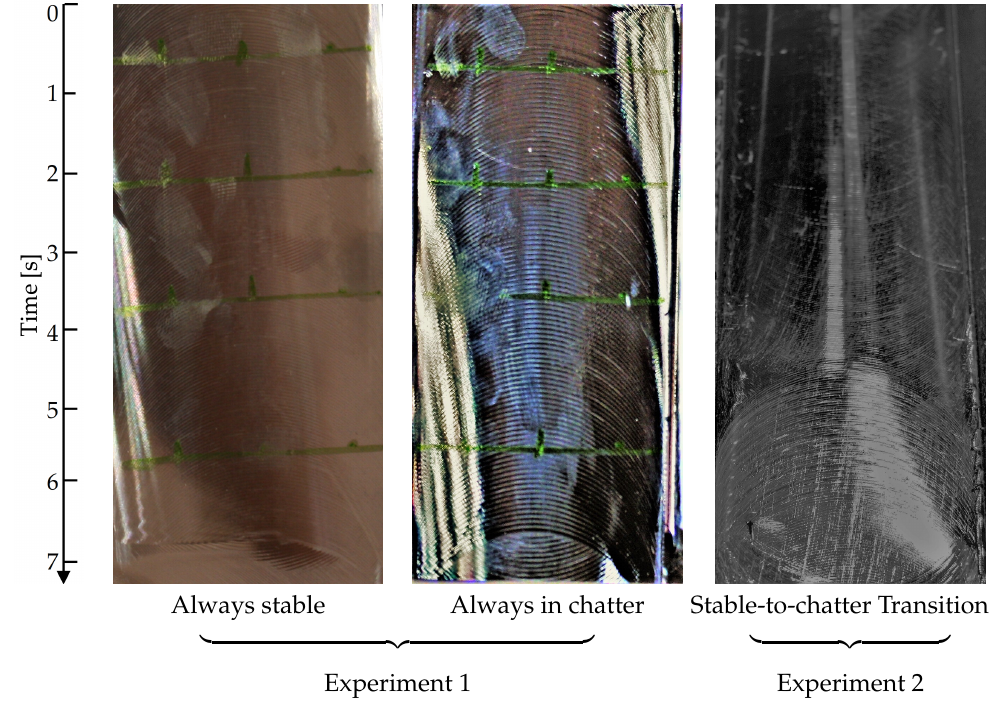
Figure 5. Workpiece surface